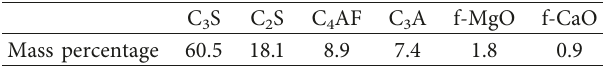
Table 1: The primary mineral composition of 42.5 ordinary Portland cement wt.%.